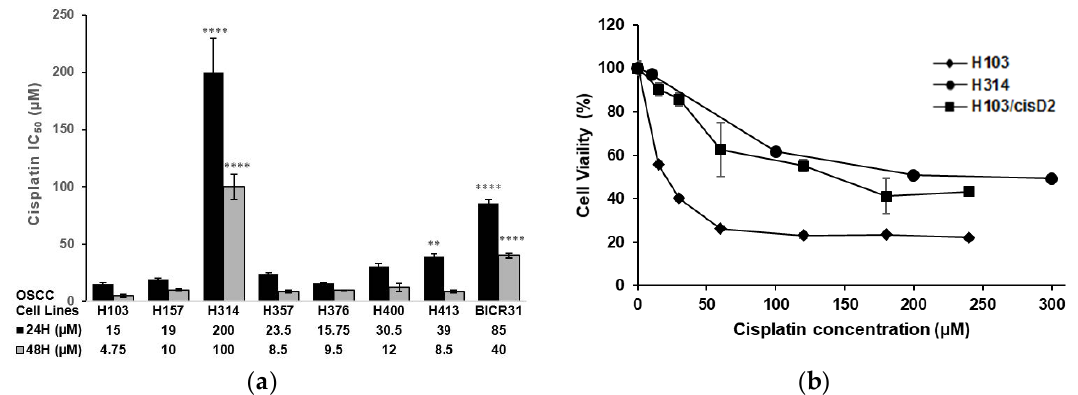
Figure 1. Cisplatin responses of oral squamous cell carcinoma (OSCC) cell lines. ( a ) IC 50 of OSCC cell lines treated with cisplatin for 24 and 48 h. Data were expressed as mean of at least 4 replicates. IC 50 with significant di ff erence compared to H103 cell lines were indicated with asterisks ( n = 4, ** p < 0.01, **** p < 0.0001); ( b ) Cisplatin response curve of the H103 and H103 resistant subline, H103 / cisD2 and H314 for 24 h. IC 50 for each cell line was determined by interpolating at 50% cell